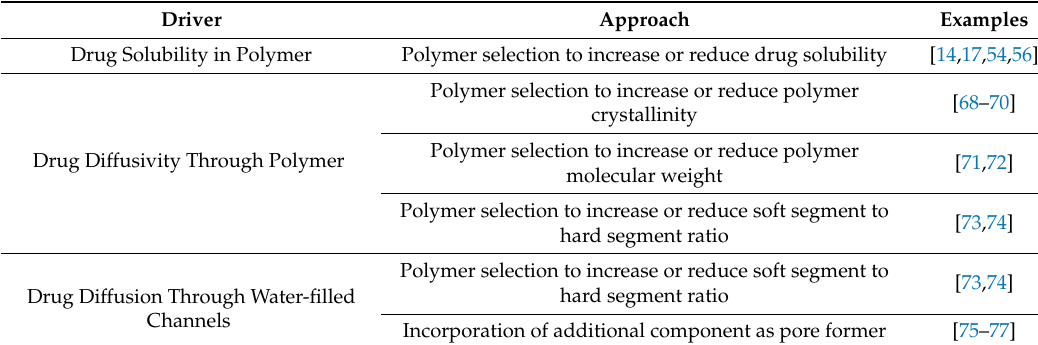
Table 2. Approaches to Modulate Drug Release Kinetics from a Polyurethane-based Reservoir Sustained Release Dosage